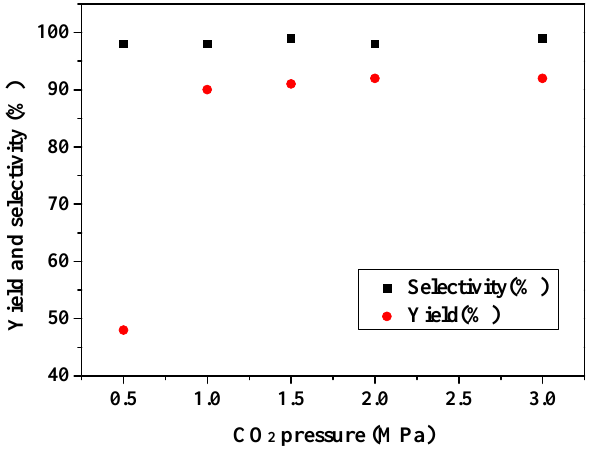
Figure 1. Influence of ZnI 2 loading on propylene carbonate (PC) yield and selectivity. Reaction conditions: propylene oxide (PO) 34.5 mmol, GndCl 1.0 mmol, CO 2 pressure 1.0 MPa, 100 °C, 1.5 h.